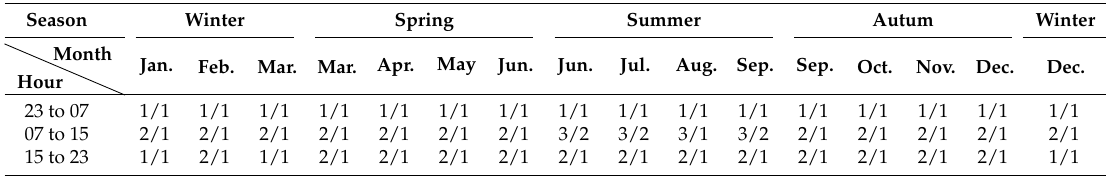
Number of connected transformers that minimize losses on Sec SS 3 at each shift